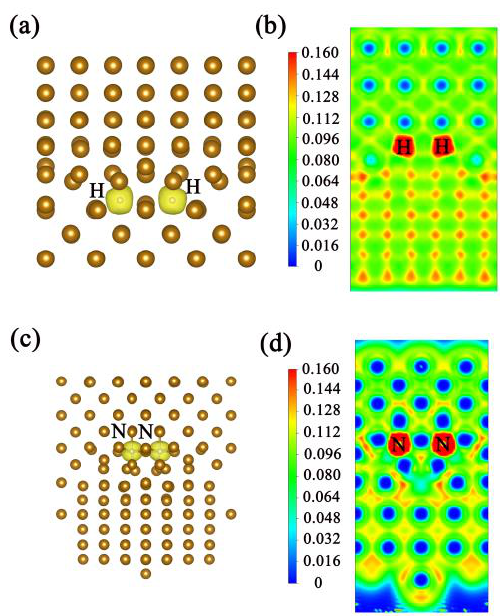
Figure 6. DOS of two atoms at the interface after optimization. ( a , b ) The DOS of hydrogen and nitrogen atom at the interface, respectively.